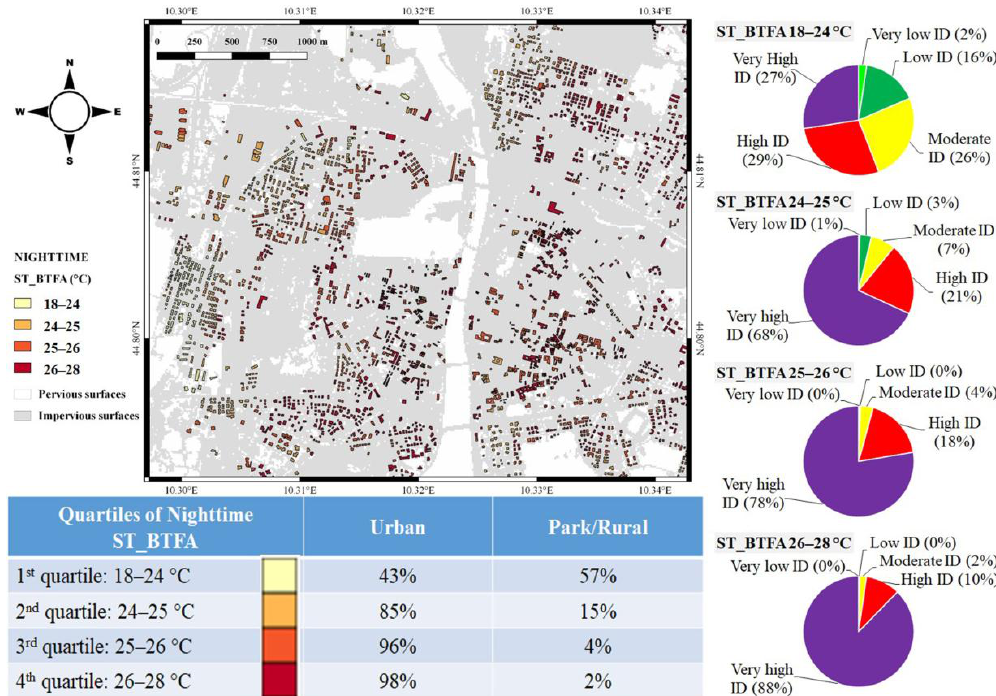
Figure 5. Maps of daytime quartiles of surface temperatures nearby residential buildings (ST_BTFA) on 30 June 2015 in the city center of Parma. The pie charts on the right show the residential building frequencies for each ST_BTFA quartile observed in different imperviousness density (ID) groups. The table shows the building frequencies for each ST_BTFA quartile observed in urban and park/rural areas. Remote Sens. 2017 , 10 , 26 10 of 18